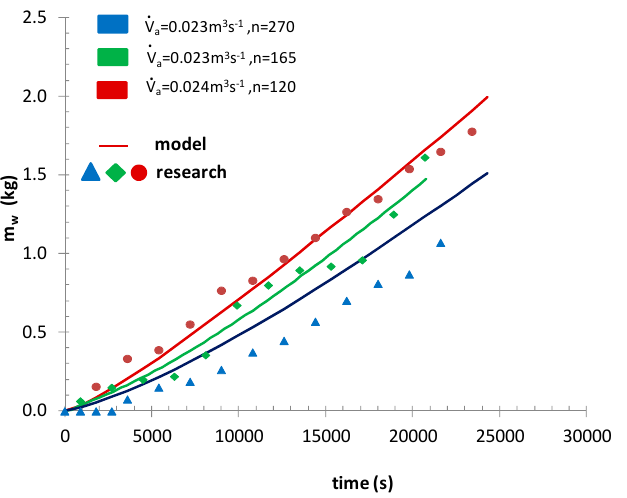
Figure 4. Comparison of the calculated and experimental values of the amount of water removed from honey as a function of time m w ( τ ), for V a ≈ 0.023–0.024 m 3 s − 1 .